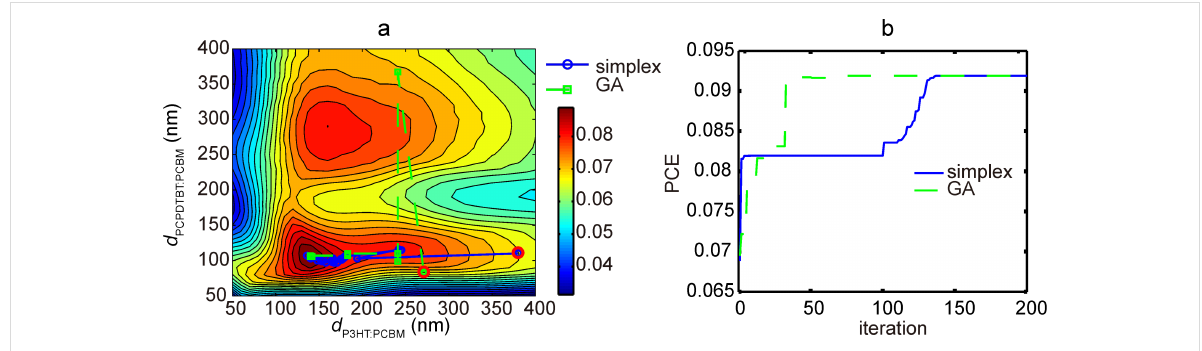
Figure 9: (a) Presents the evolution of optimized active layer thicknesses during the search of the optimal PCE value. Both the simplex searching algorithm and GA are tested. The random start points are indicated by the red circles. The corresponding PCE value evolutions are displayed in (b). Here, the weight ratios are 1:2 for both P3HT/PCBM and PCPDTBT/PCBM.